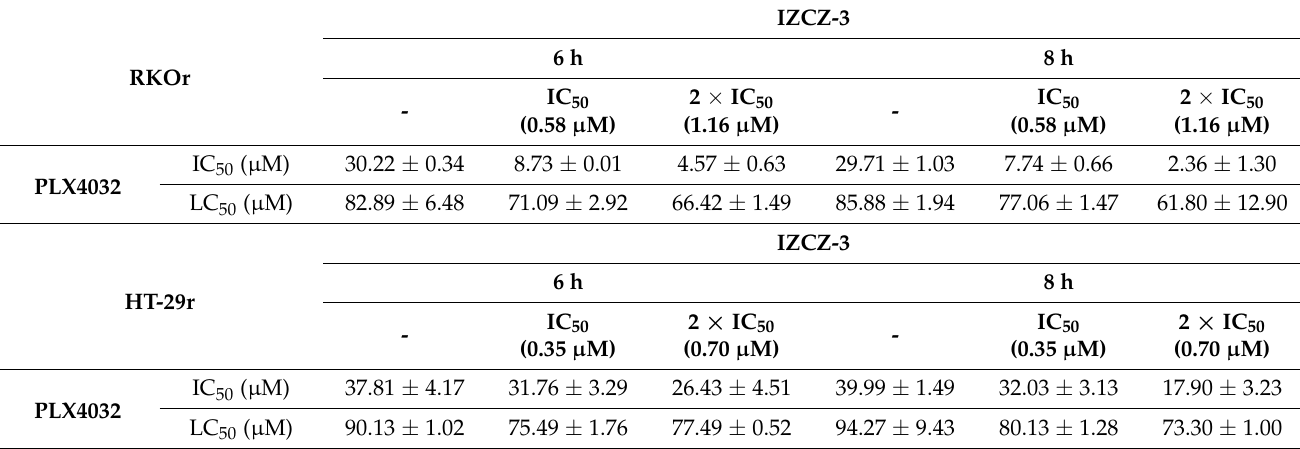
Table 6. Anti-proliferative effect of PLX4032 in BRAF mutant colon cancer cells with acquired resistance to PLX4032 after 6- and 8-h pre-treatment with cytotoxic concentrations of c-Myc transcription inhibitor IZCZ-3 measured by the MTT assay. Shown here are the results from two independent experiments expressed as mean ± standard